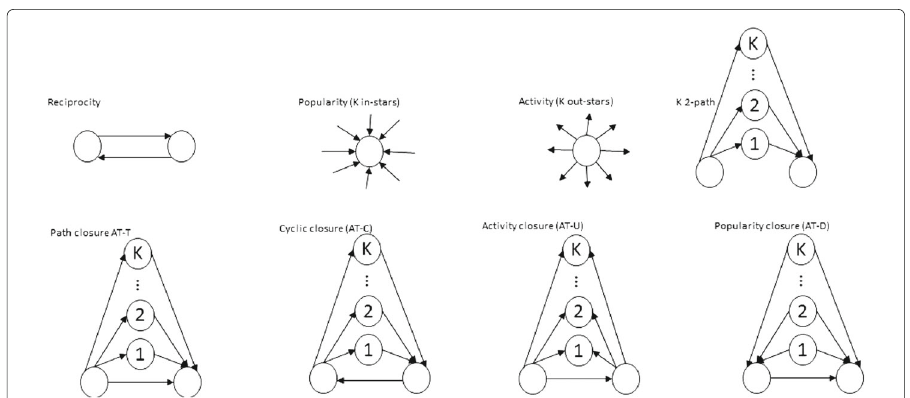
Fig. 4 Illustrations of the different considered network statistics. More detailed explanations can be found in Lusher et al.